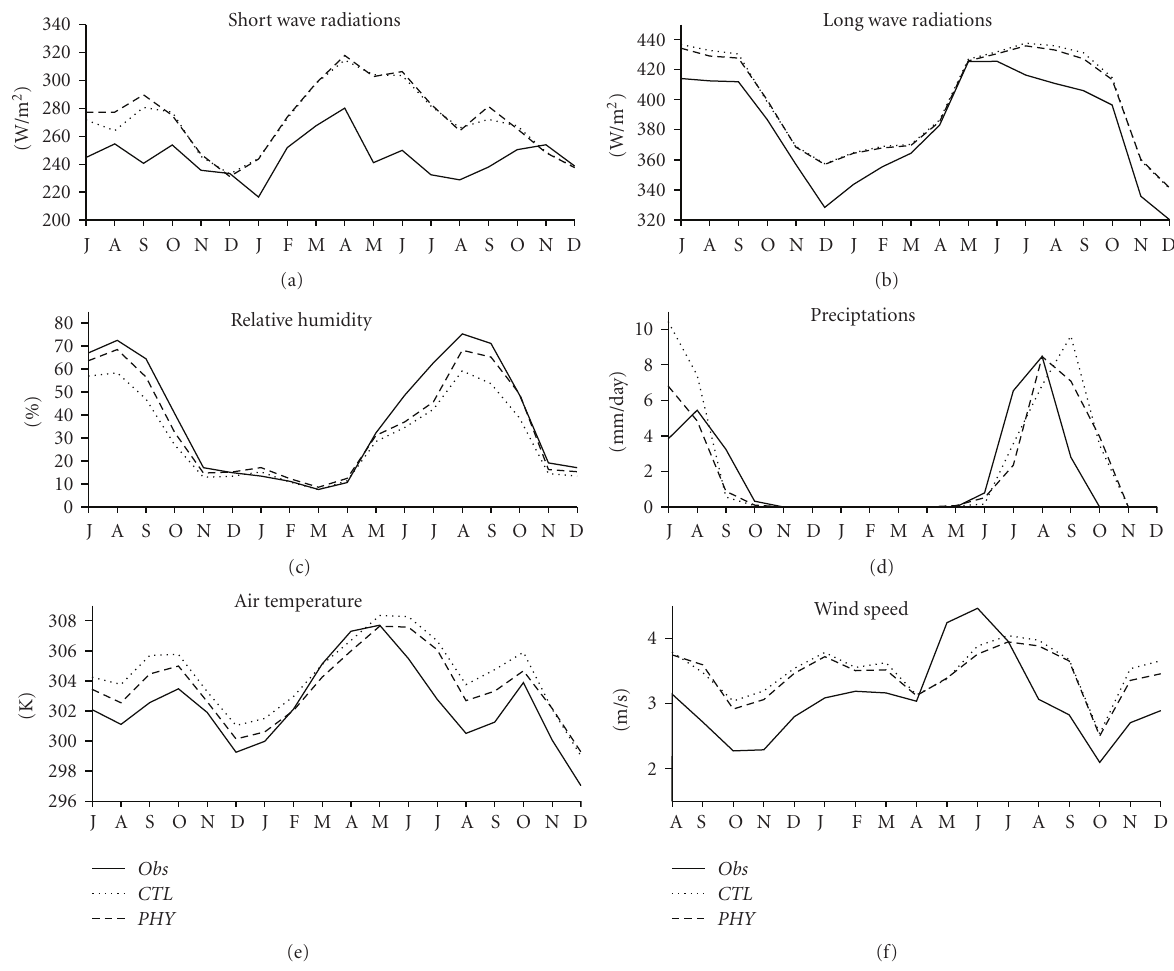
Figure 7: Monthly comparison between in-situ and simulated surface atmospheric variables over the Wankama watershed. All related statistics are given in Table 1. Table 2: As in Table 1 but for the surface energy budget variables: surface net radiation, Rn (W/m 2 ); ground heat flux, G (W/m 2 ); latent heat flux, LE (W/m 2 ); sensible heat flux, H (W/m 2 ).